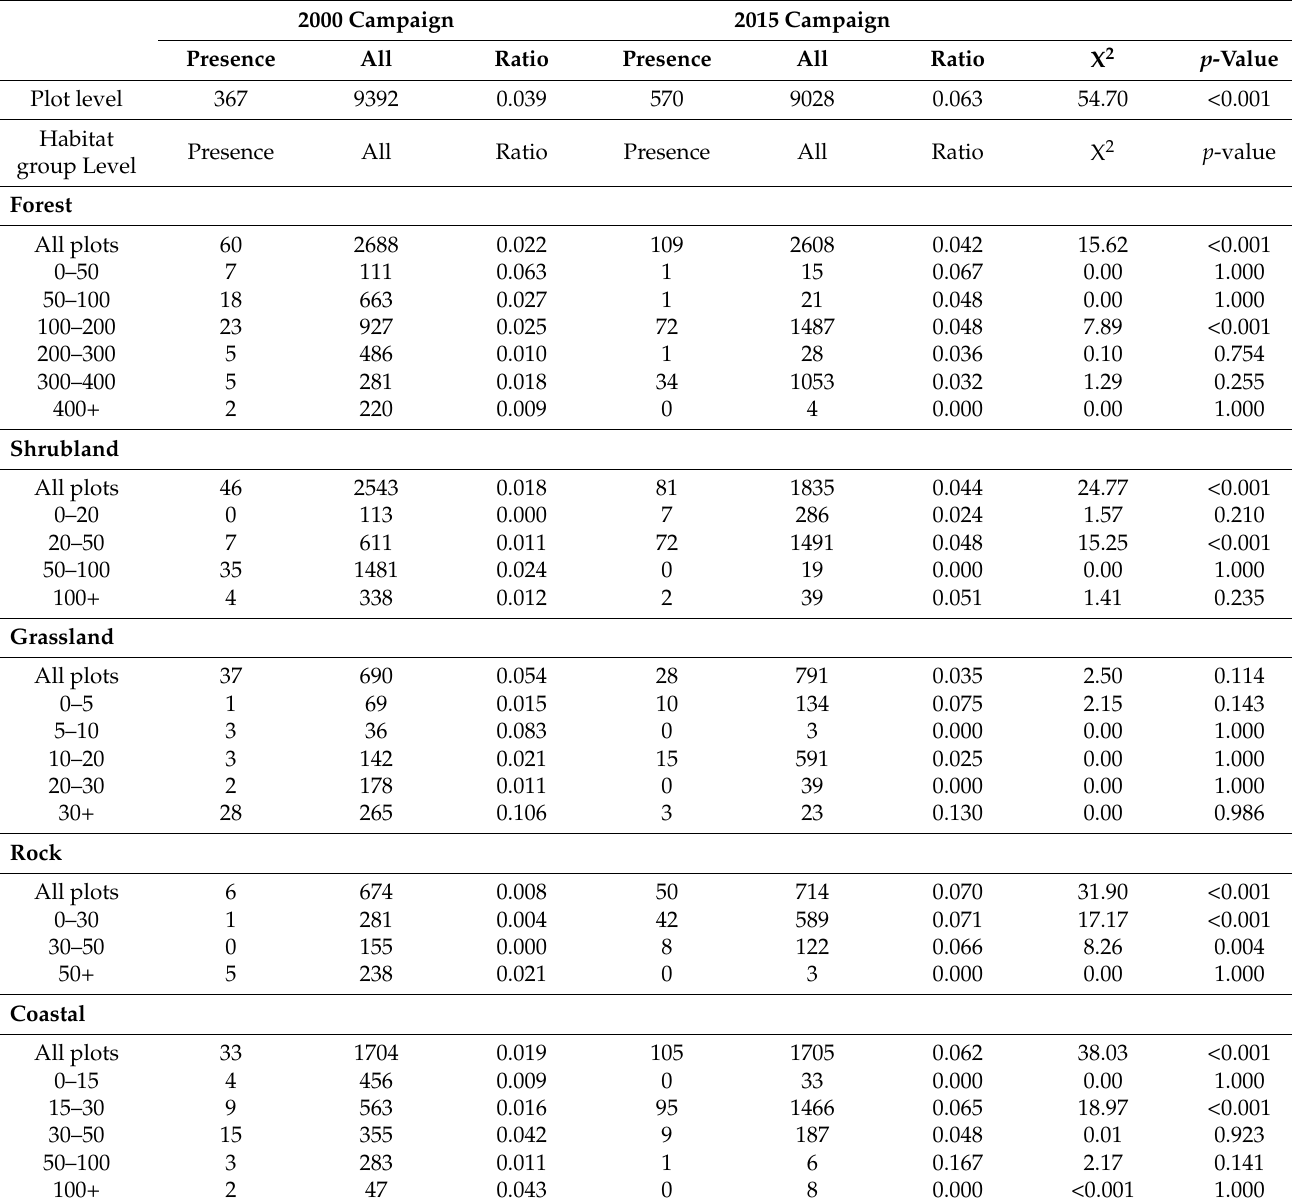
Table 2. Comparison of the number of invaded sampling plots between the two reference